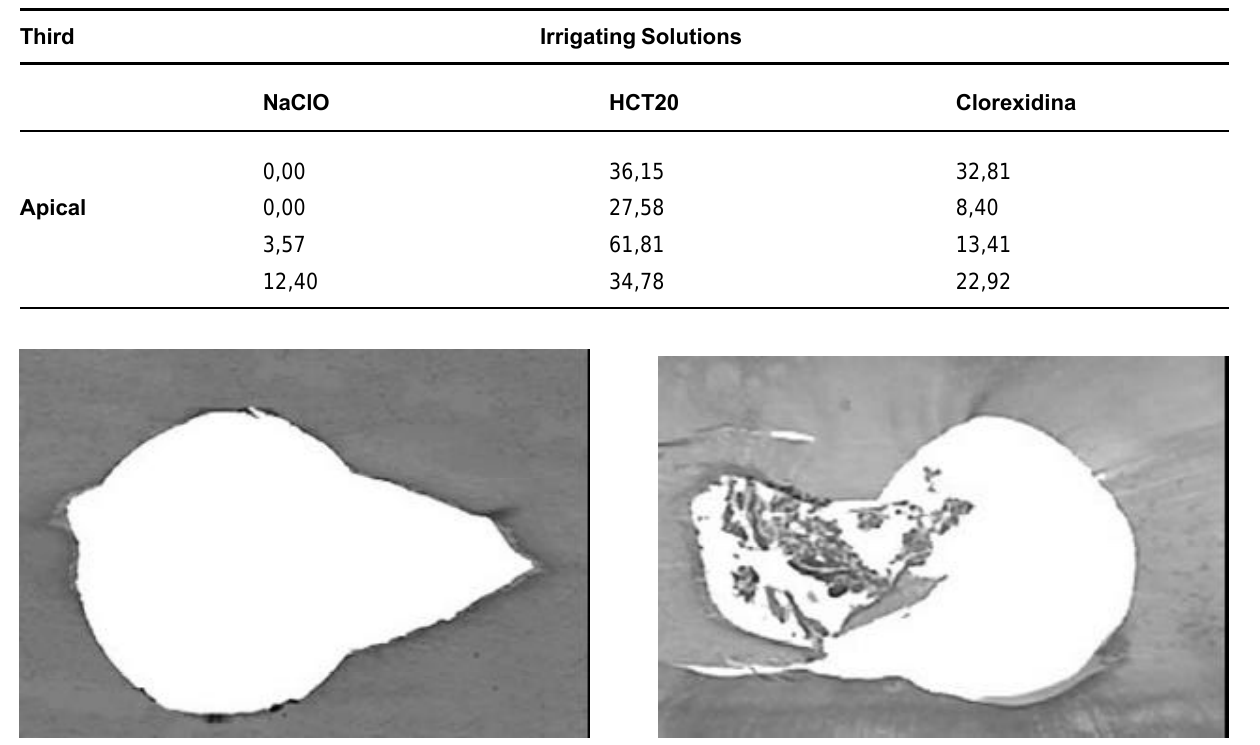
FIGURE 1- Slide showing a root canal from group 1, with the presence of pre-dentin